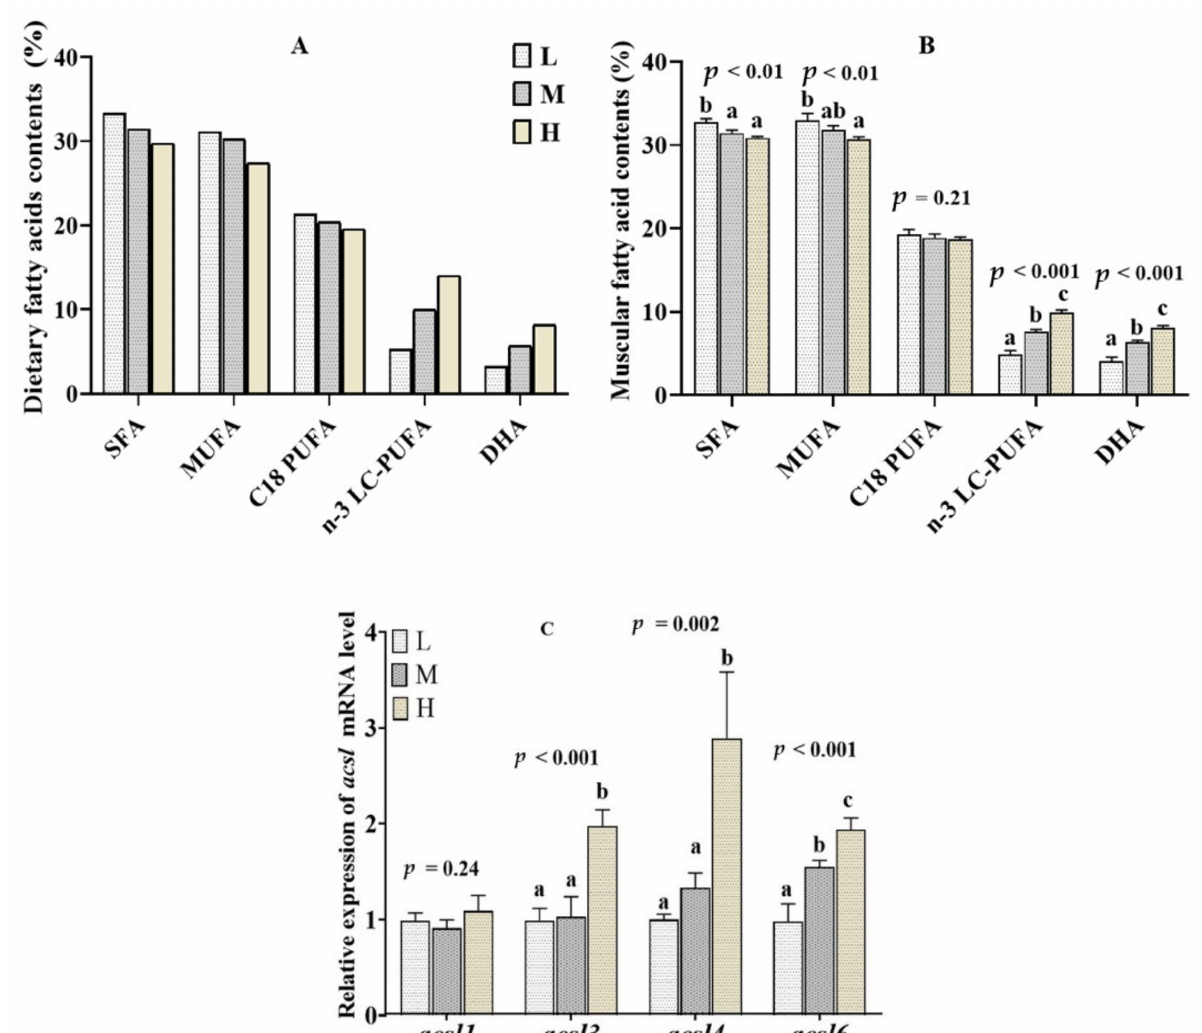
Figure 4. Muscular fatty acid contents ( B ), and acsl family mRNA relative level ( C ) of juvenile Trachinotus ovatus fed diets with different n-3 LC-PUFA levels ( A ). Values are means ± SEM from three treatments of fish ( n = 3) with three fish per cage, and bars not sharing a common letter indicated significant differences ( p < 0.05) among deletions determined by one-way ANOVA followed by Tukey’s multiple